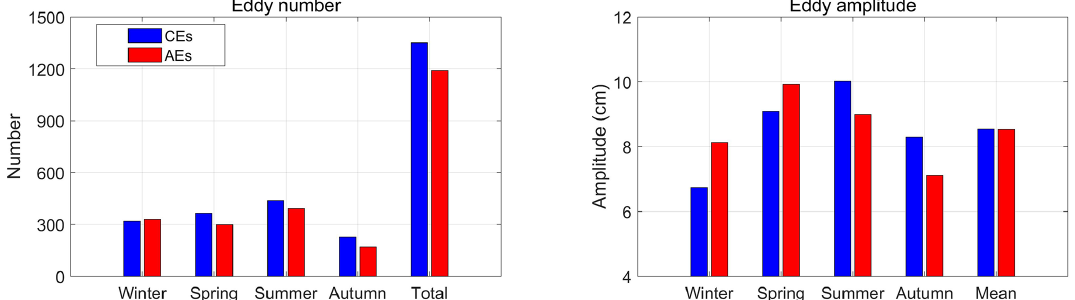
Figure 3. The eddy number and amplitude of monthly cyclones (CEs) and anticyclones (AEs) in different seasons based on monthly averaged sea level anomaly fields from January 1993 to February 2019 in the Bay of